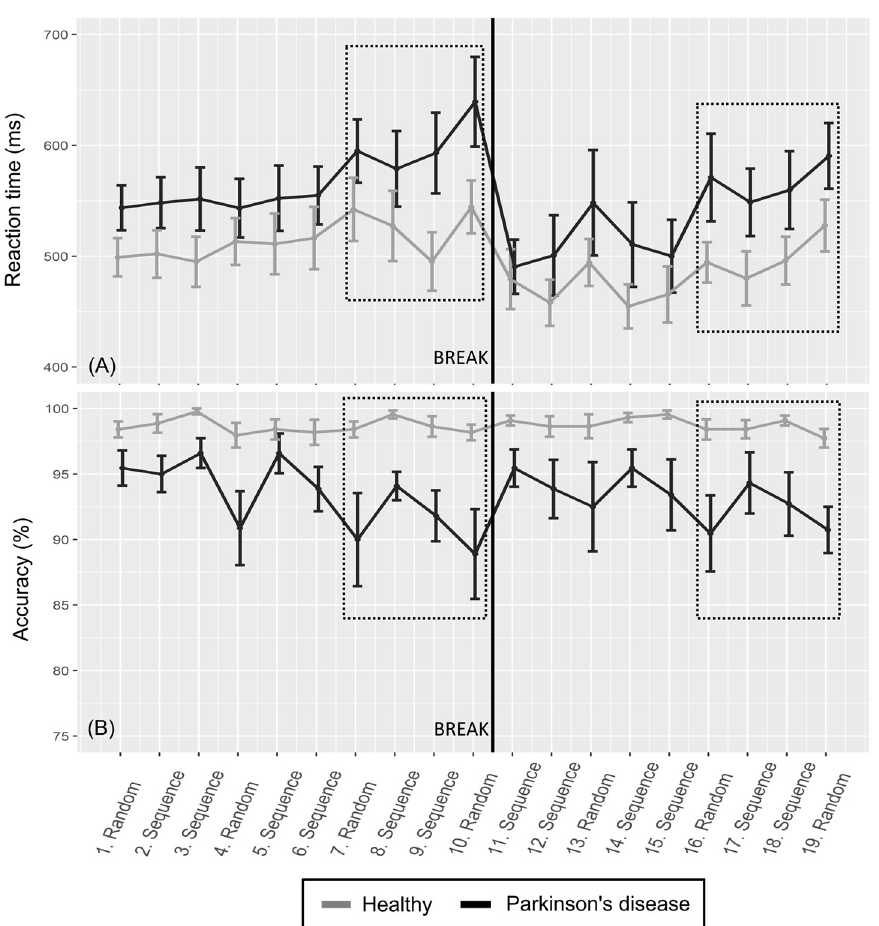
Fig 3. Reaction time and accuracy of the SRTT. (A) Means and standard errors (+1,––1) of the RTs over all blocks for the two groups. (B) Means and standard errors (+1,––1) of accuracy over the all blocks for the two groups. The squares indicate the blocks used for the descriptive statistics of implicit sequence learning where the performance on the random blocks was compared with the performance on the sequence blocks.